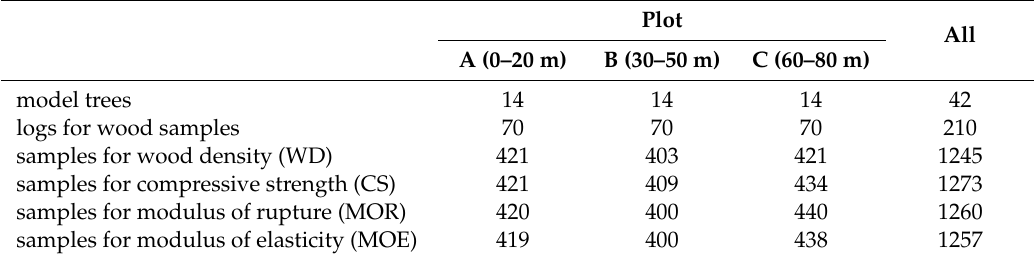
Table 2. Numbers of model trees, logs, and samples.